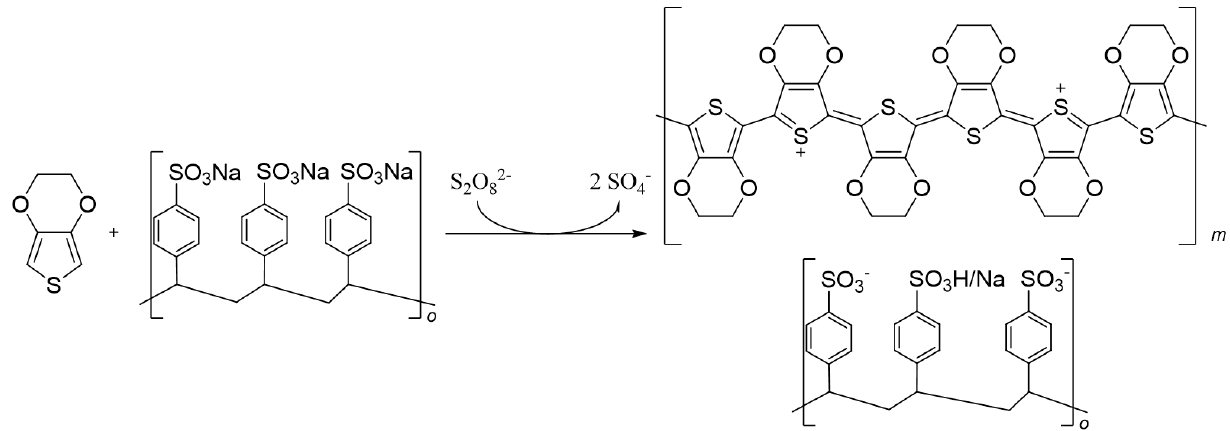
Figure 3. (3,4-ethylenedioxythiophene) (EDOT) polymerization reaction in presence of poly(styrenesulfonate) (PSS).